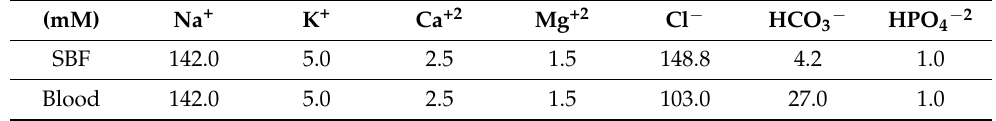
Table 1. Inorganic ion concentrations of SBF and human blood